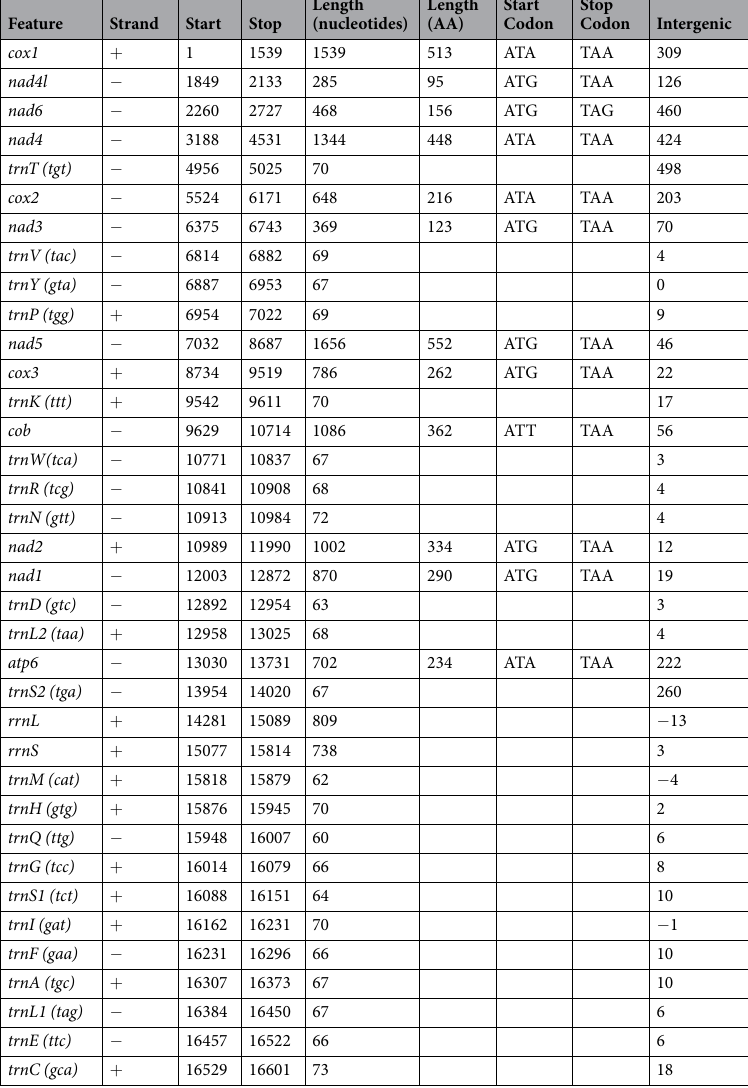
Table 3. Organisation of the Archaphanostoma ylvae 16.6 kb mitochondrial